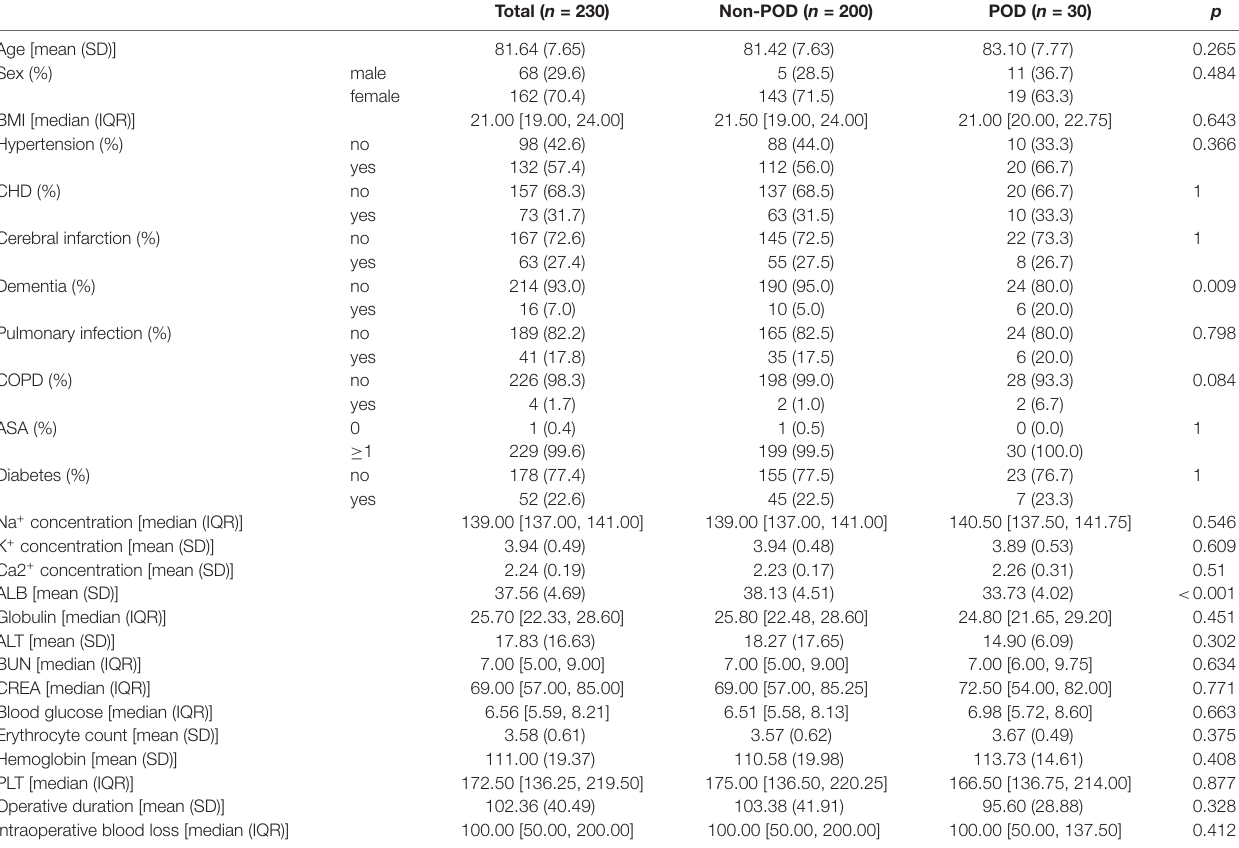
TABLE 2 | Patient characteristics of the training set.